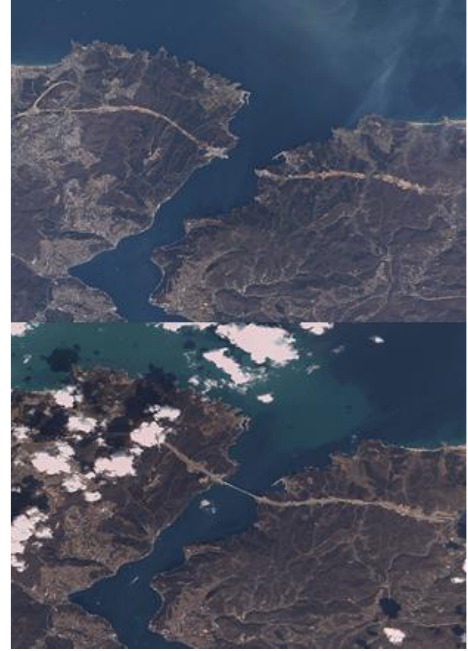
Figure 11. RASAT imagery showing construction of Yavuz Sultan Selim Bridge over the Bosphorus, (top) before construction began in 2014 and (bottom) current state of construction in